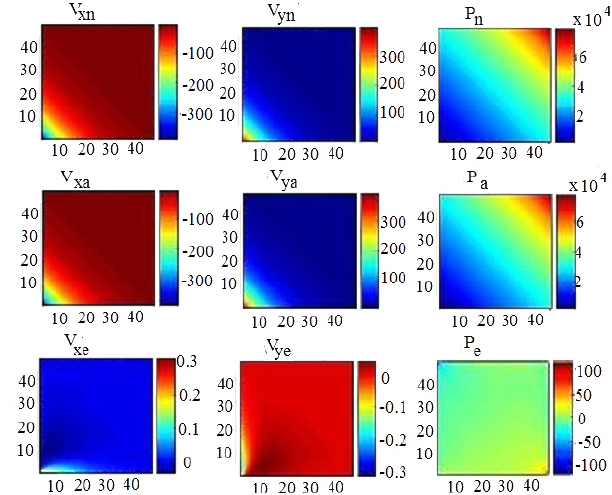
Figure 3. Logarithm of the relative error (log E ) via logarithm of the grid step (log H ); 2-D case, linearly varying viscosity, high- viscosity contrast ( η 2 = η 3 = 100); blue lines – pressure, green lines – v x , black lines – v y ; solid lines – L 1 -error, dashed lines – L ∞ -error, solid dotted line – L 2 -error.